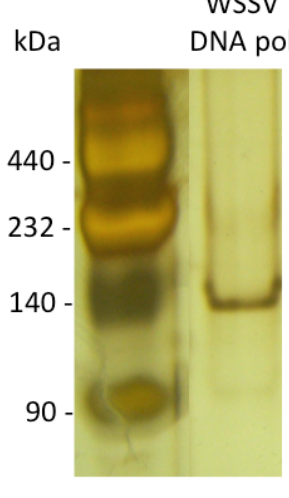
Figure 3. Purification of WSSV DNA pol. Native silver-stained gel of purified WSSV DNA pol